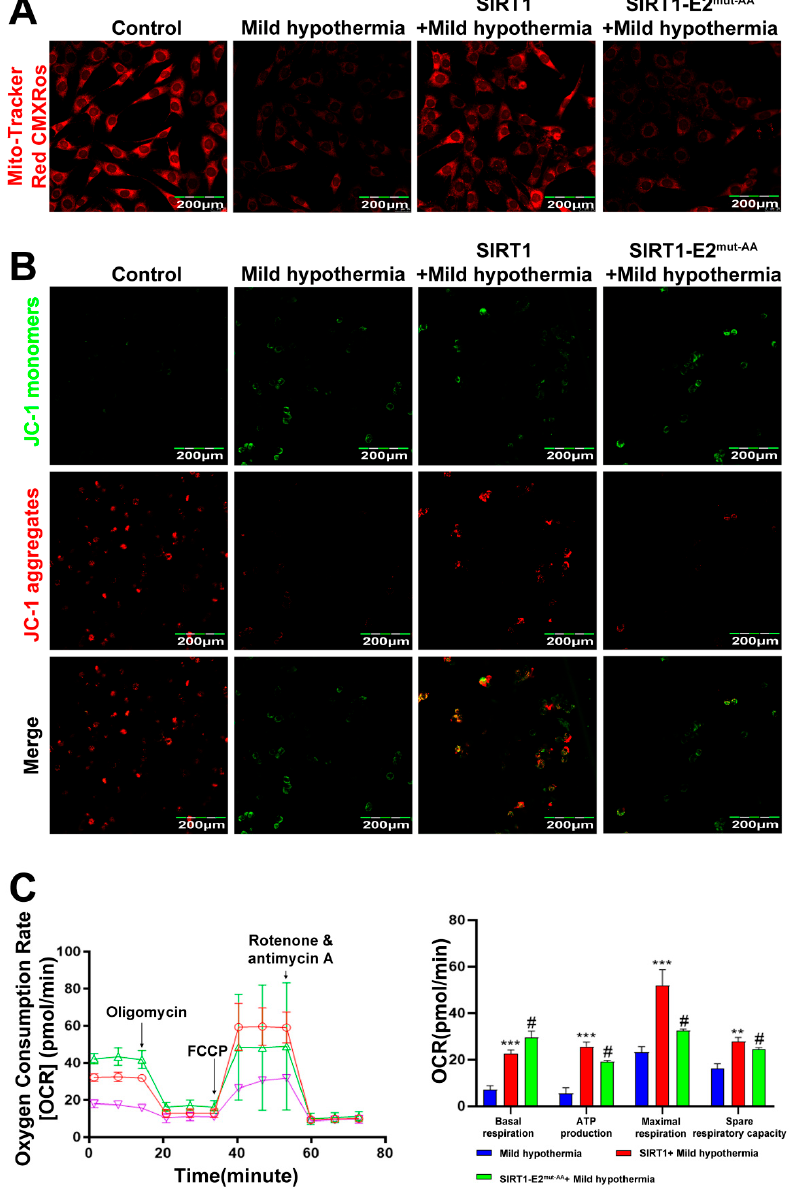
Figure 8. SIRT1 overexpression rescues CS-induced mitochondrial damage. After treatment, C2C12 cells were collected and stained with ( A ) MitoTracker™ Red CMXRos and ( B ) JC-1. ( C ) Mitochondrial function (i.e., basal respiration, ATP production, maximum respiration, and reserve respiratory capacity) was assessed with the cellular mitochondrial pressure test. All results contain 3 repli- cates per group (n = 3/group). Data are presented as means ± sd and were analyzed by one-way ANOVA. * compared to mild hypothermia group, ** p < 0.01, *** p < 0.001; # compared to SIRT1+mild hypothermia group, # p <